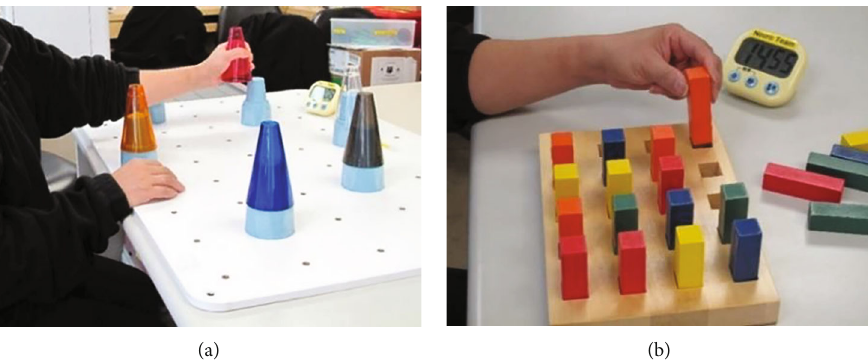
Figure 2: Motor task practice. Two motor tasks were involved: (a) A pegboard with fi ve targets of the same size placed in a semicircle at arm ’ s length was used. Participants were asked to grasp one of the fi ve cones placed in the middle near the edge of the table and then reach and place it on top of the speci fi c target that fi tted the size of the cone. The same task was repeated until all fi ve cones were placed on their respective targets. Participants were then required to reach and grasp the cones one by one and place them back to the original position in the middle. These movement sequences were repeated until the 15-minute mark. (b) A pegboard with rectangular blocks was placed in front of the participants, who were then asked to take the block one by one out of the pegboard and then put on the table. After all the blocks were removed from the pegboard, the participants were required to put the block one by one back onto the pegboard. These movement sequences were repeated until the 15-minute mark (Figure 2). In both motor activities, participants were encouraged to perform the tasks as e ffi ciently as possible, without dropping the object on the